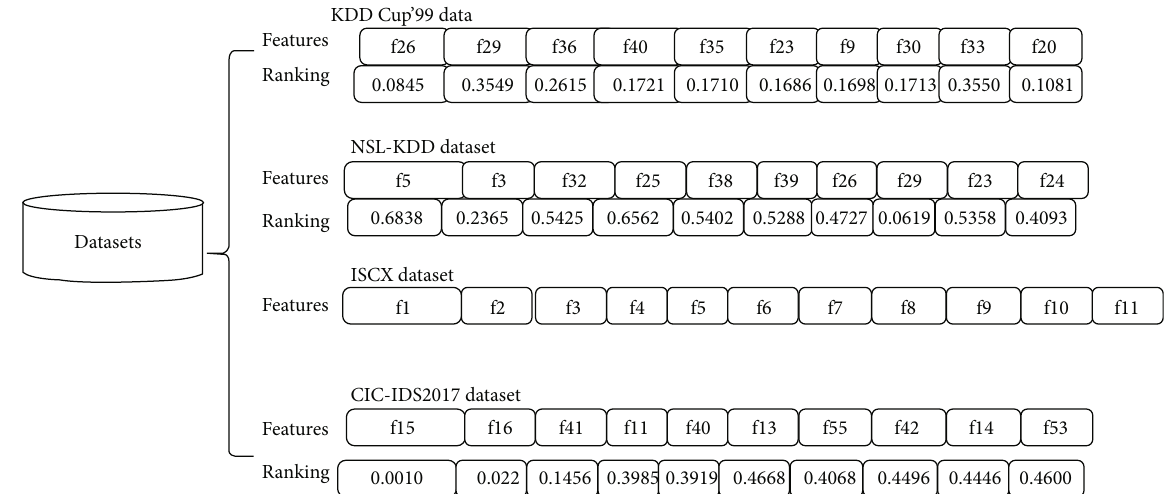
Figure 4: The signi fi cant features with ranking values from the